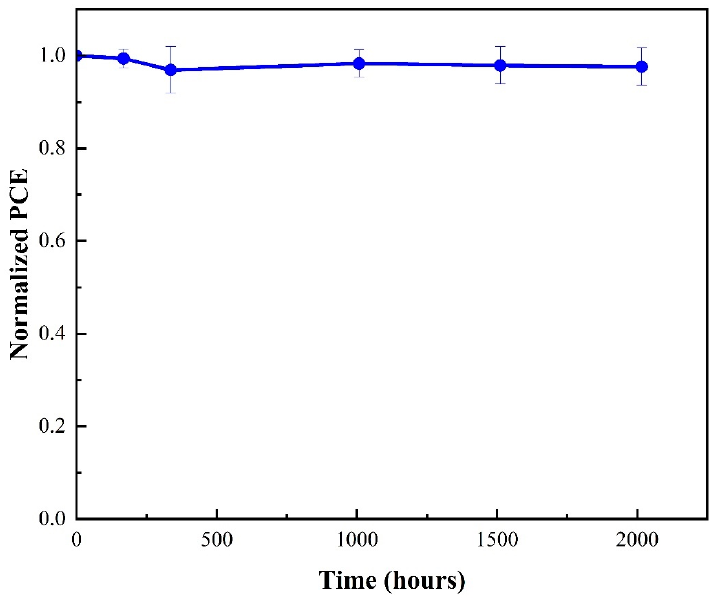
Figure 6. Stability data of unsealed devices from superimposed HiPIMS under the argon glove box. Table 3. Superimposed HiPIMS device with dim